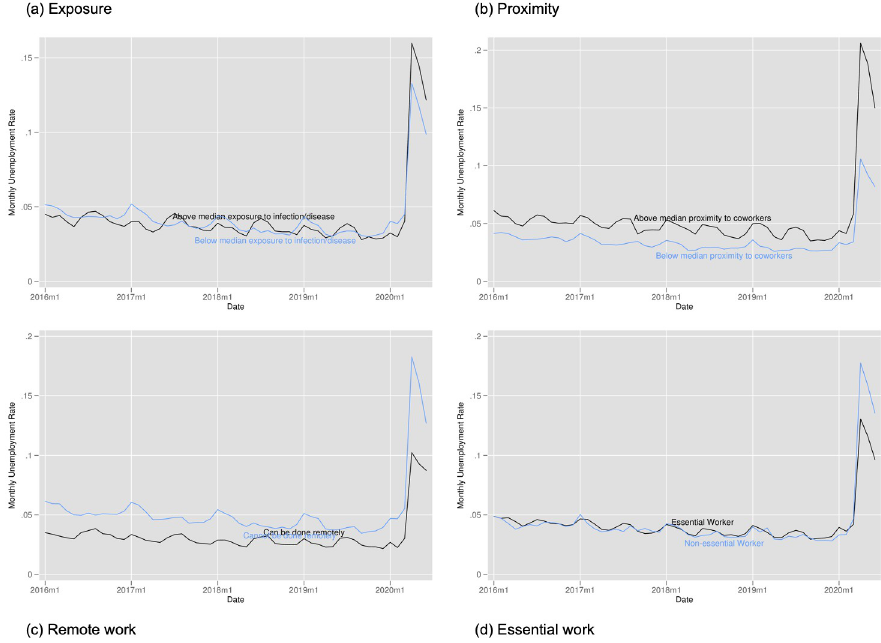
Fig 7. Unemployment rate by exposure to disease, proximity to coworkers, remote work, and essential work. Notes: Authors’ calculations. Data from the Current Population Survey. The time period is January 2016 to June 2020. Each panel plots the unemployment rate. Panel A for individuals in occupations above and below the median for our index of exposure to the disease. Panel B for individuals in occupations above and below the median for our index of proximity to coworkers. Panel C for individuals in occupations designated by [1] as being able to be done remotely. Panel D for individuals in occupations designated as essential and non-essential by the Labor Market Information